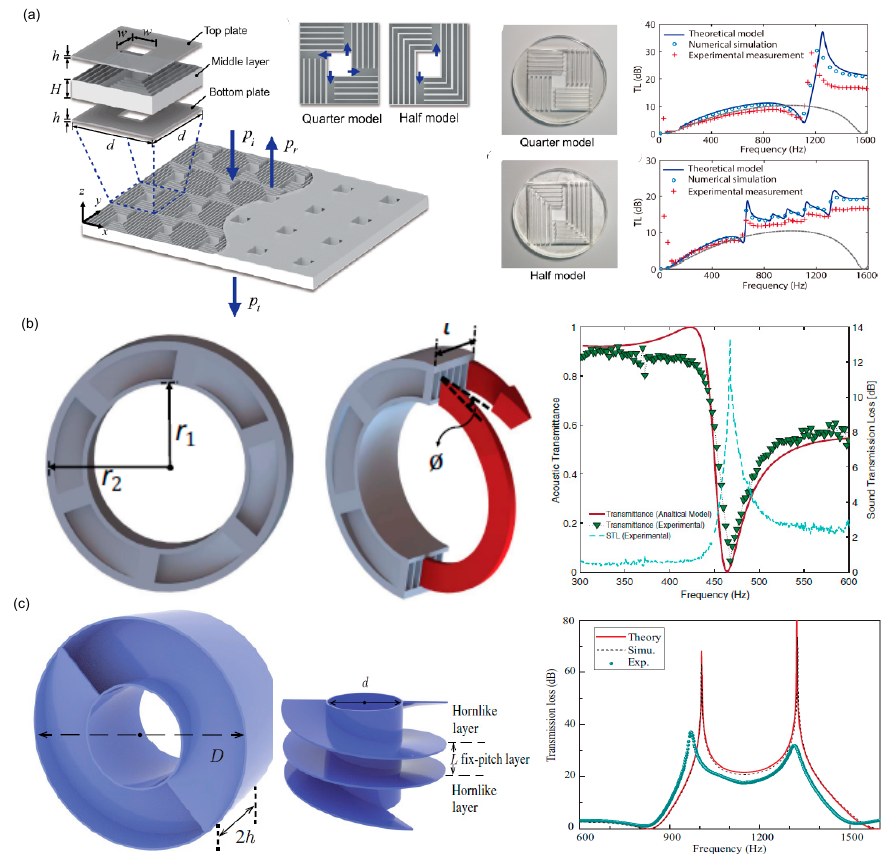
Figure 5. ( a ) Schematic diagram of the slow-wave metamaterial open panel composed of periodically repeated subwavelength unit cells. Photographs of 3D printed samples (12 mm thickness) and their corresponding transmission loss spectra are shown. Reprinted with permission from Yang et al. [96] , ©2018 AIP Publishing LLC. ( b ) Schematics of the ultra-open metamaterials composed of the central open region and the transverse bilayer structure, featuring six channels coiled in the helix form. The simulated (solid red line) and experimental (dotted green line) acoustic transmittance spectra with the measured sound transmission loss spectrum (dashed blue line) are shown. Reprinted with permission from Ghaffarivardavagh et al. [99] , © 2020 American Physical Society. ( c ) Schematics of a helical meta-unit cell composed of two parts: the central hollowed-out orifice and the surrounding helix and transmission loss spectra of the helical meta unit, theoretical (red line), simulated (black dashed line), and measured (green dots). Reprinted with permission from Sun et al. [100] , © 2020 American Physical Society.